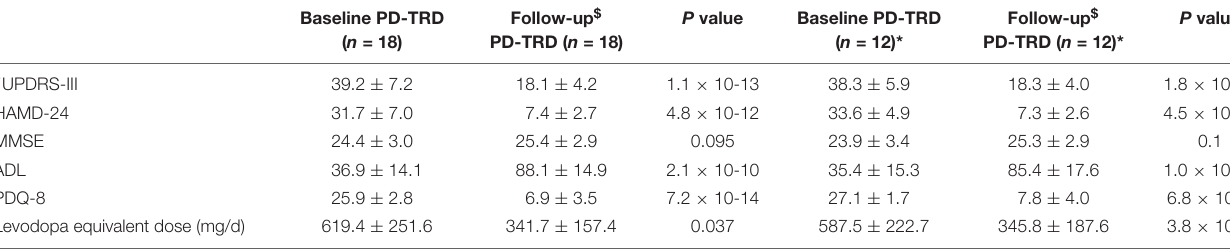
TABLE 2 | Clinical measurements before and after STN-DBS for PD-TRD patients.